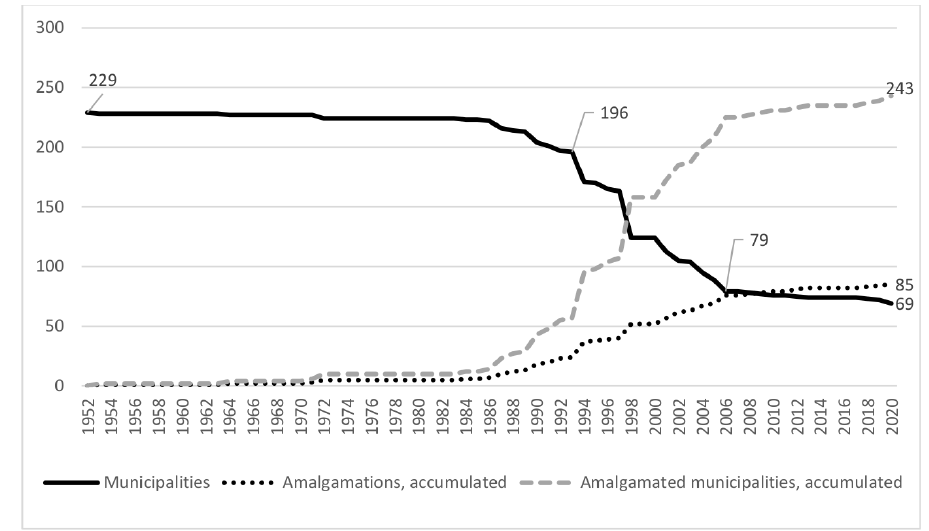
Figure 1: Number of municipalities in Iceland, amalgamations and amalgamated muni- cipalities